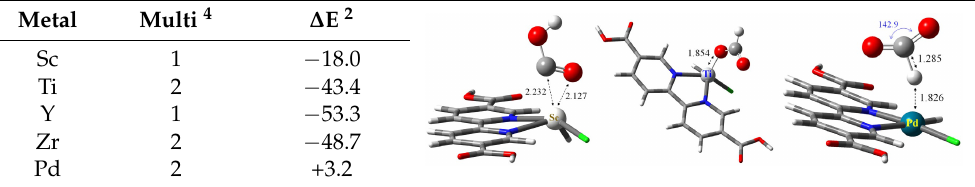
Table 1. The hydride transfer results of MCl(H) 2 + CO 2 → MCl(H)(HCO 2 ) step 1,3 .